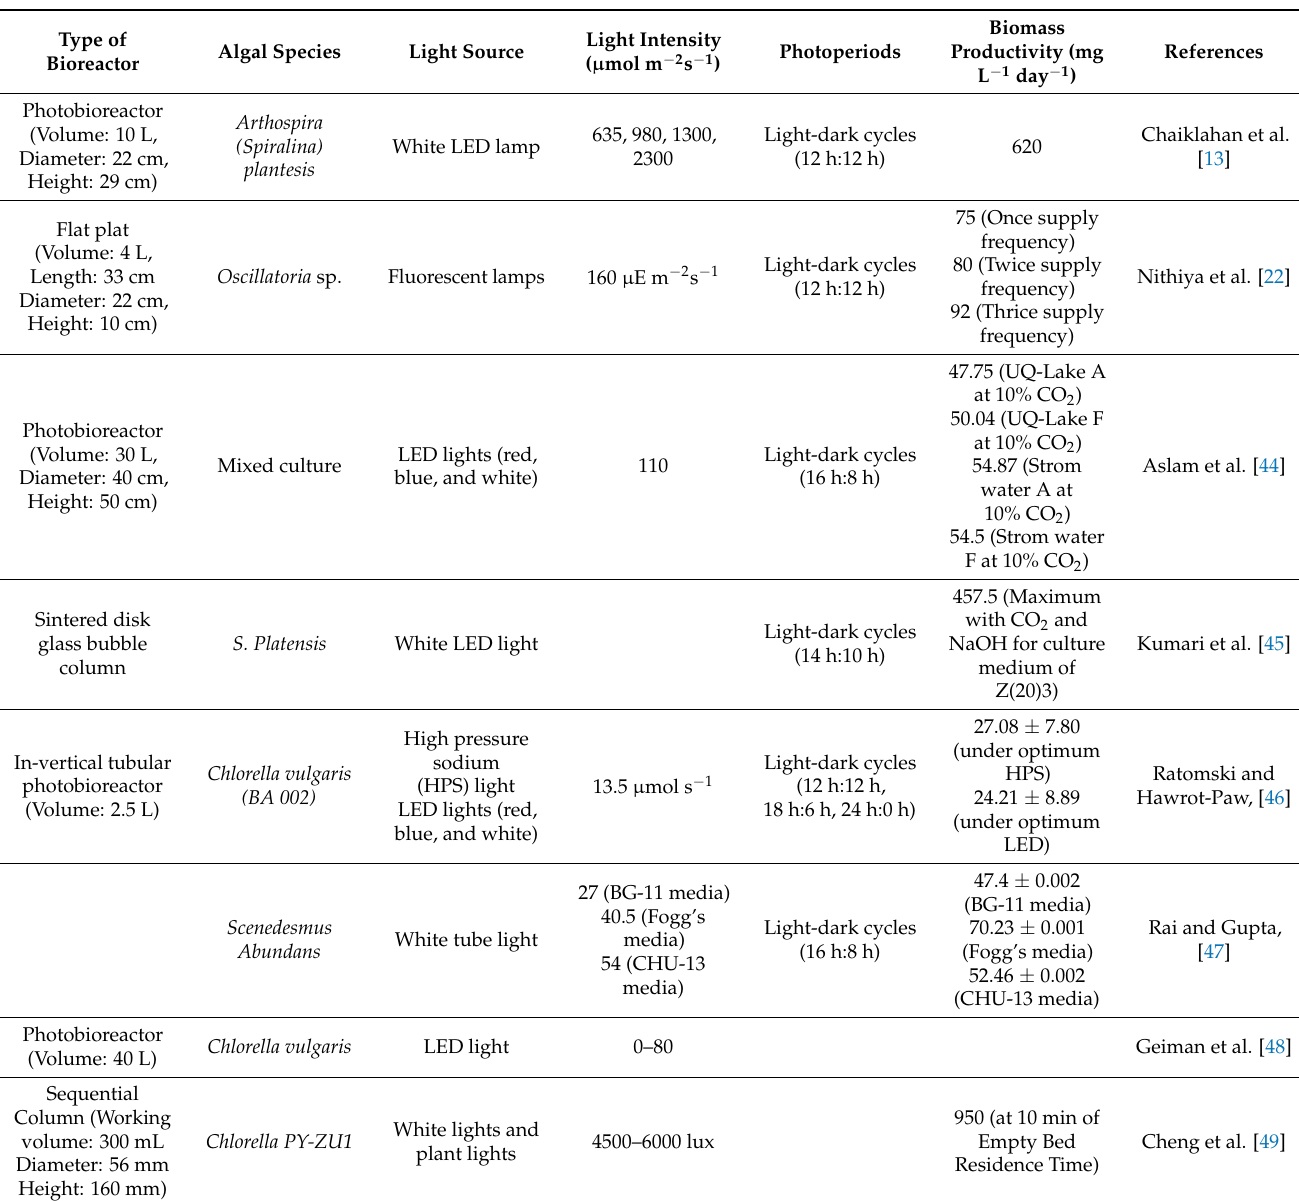
Table 3. Influence of light intensity and photoperiods on the biomass productivity of various Algal species in a variety of